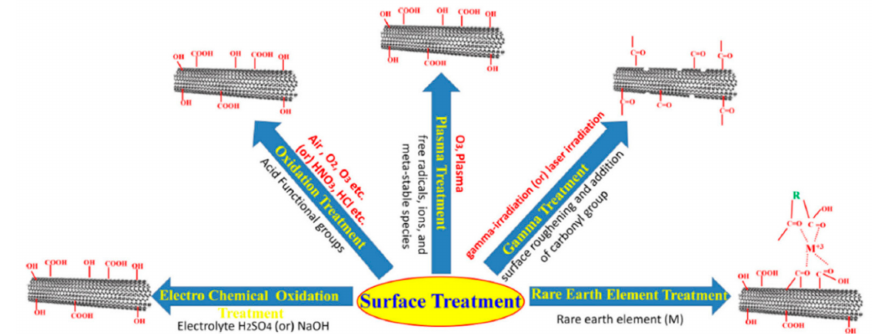
Figure 12. Diagram showing different techniques for CF surface modification. Reprinted with permission from